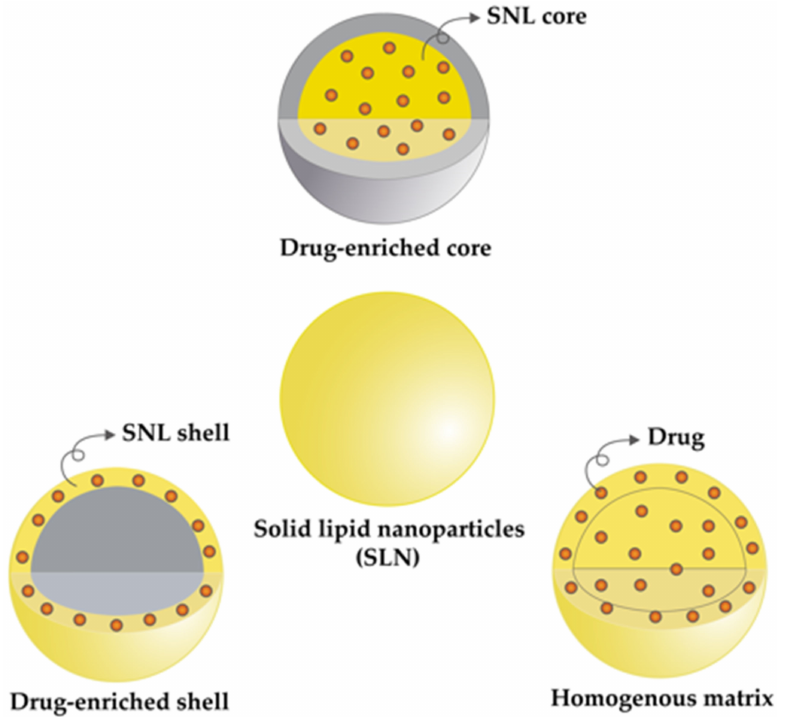
Figure 6. Different representative models for SLNs showing the drug distribution in the lipid core: Drug enriched core model, Drug enriched shell model, Homogenous matrix